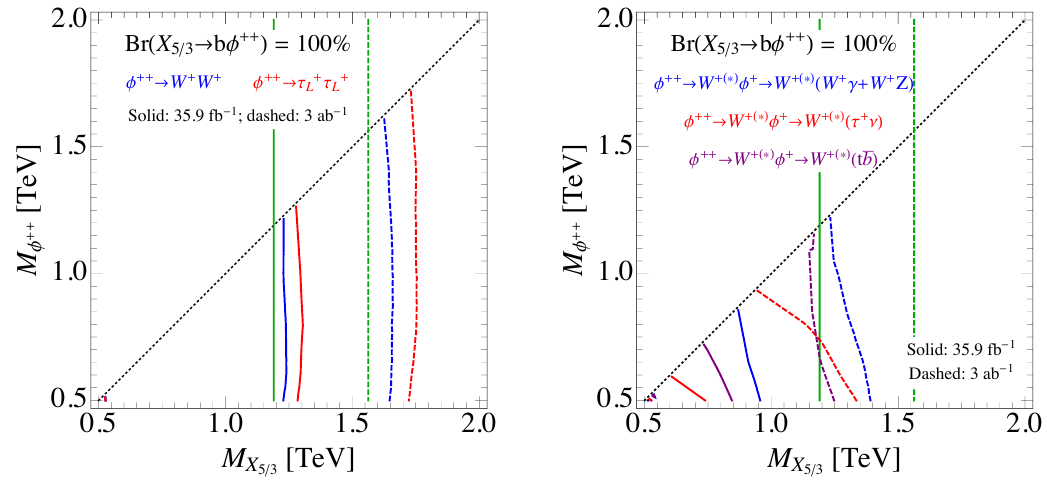
Figure 4 . Bounds on the M X { M plane from the CMS SSL search of ref. [10] (solid lines) (cid:30) ++ 5 = 3 and projections for the HL-LHC reach (dashed lines) for the various (cid:30) ++ decay modes. In the left panel we show direct decays of (cid:30) ++ ! W + W + =(cid:28) + (cid:28) + , while in the right panel (cid:12)nal states from the cascade decay (cid:30) ++ ! (cid:30) + W + (cid:3) . The bounds and projections for the standard Br( X decay are shown for reference in green lines. The bounds become insensitive to M masses above